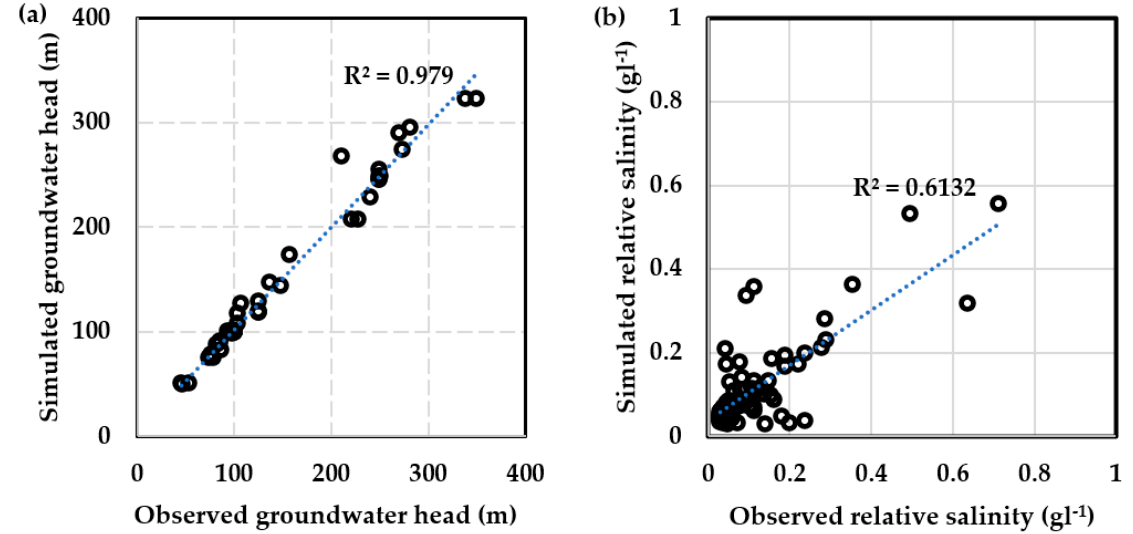
Figure 3. ( a ) Comparison of observed and simulated groundwater head (m); ( b ) comparison between observed and simulated relative salinity (gL − 1 ) at pseudo steady-state conditions.